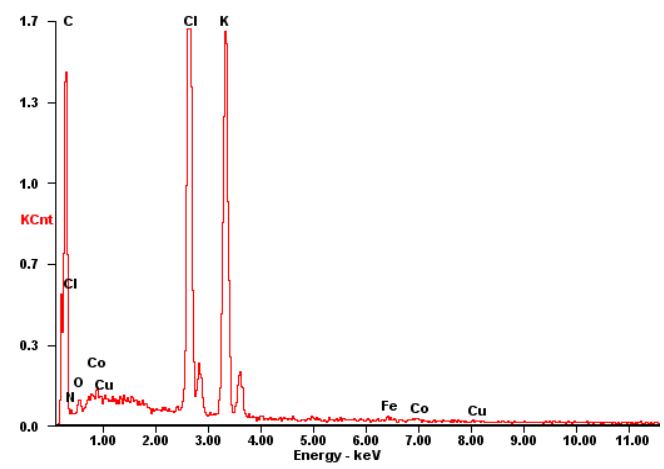
Figure 2. The EDS spectra of CuCoHCF-modified electrode.